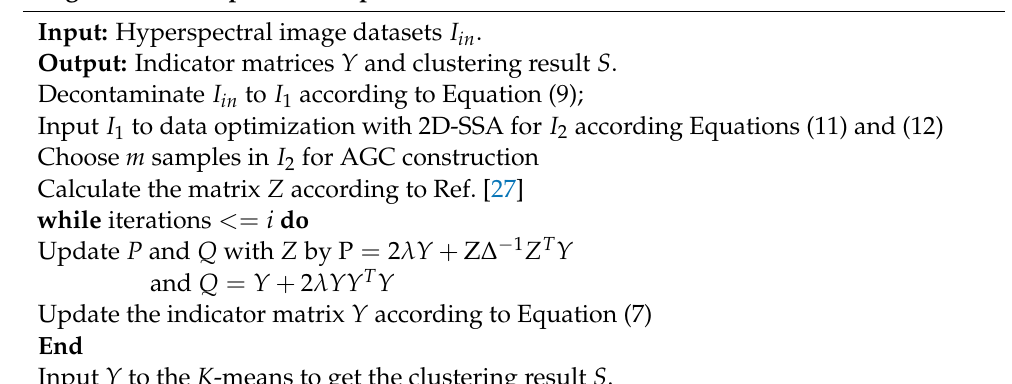
Algorithm 1: Proposed unsupervised HSI